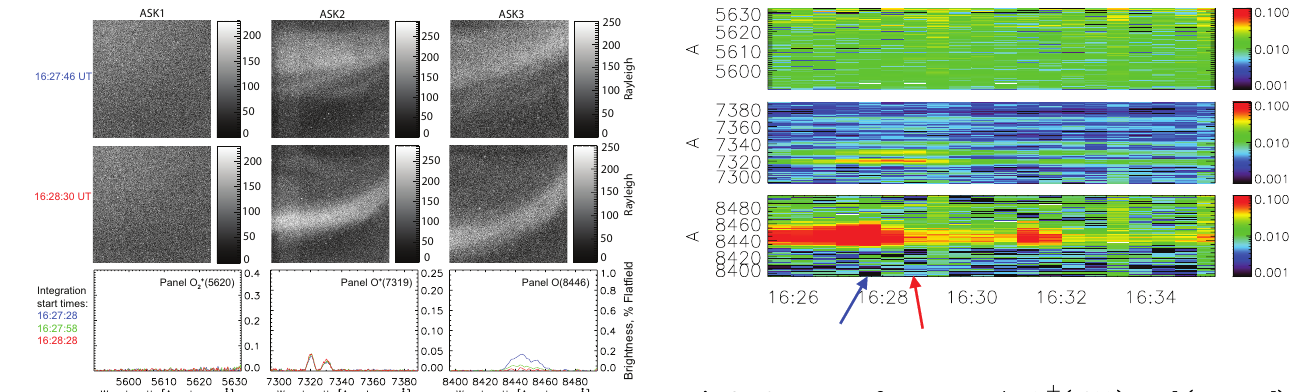
Fig. 3. SIF spectra for event 1. The O + (5620) panel (top panel), 2 detects the same emission as ASK1, and is at the noise level. In the second and third panels (panel O + (7319) and panel OI(8446)) the oxygen emissions detected by ASK2 and ASK3 during the passage of the arc are seen. The arrows indicate the time intervals in which the ASK images in Fig. 2 were taken, with the same colour emission is at the 2